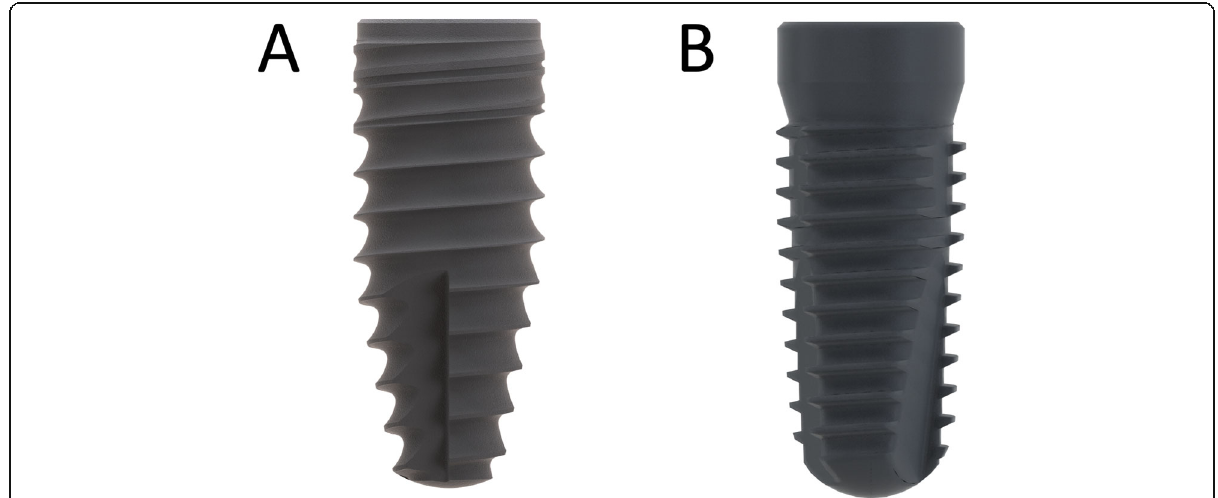
Fig. 2 External geometry of the more conical test implant ( a ) and the more cylindrical comparison implant ( b )